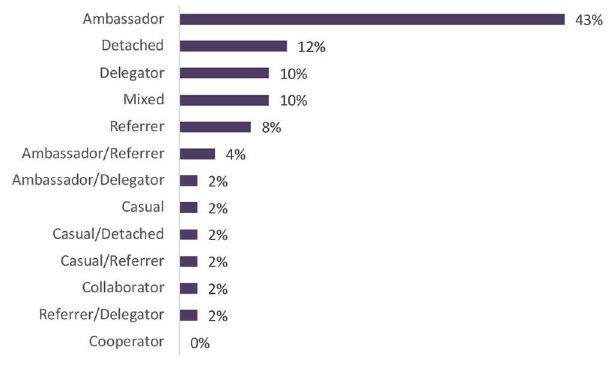
TABLE 5 | Roles adopted by professors to help students develop academic integrity.